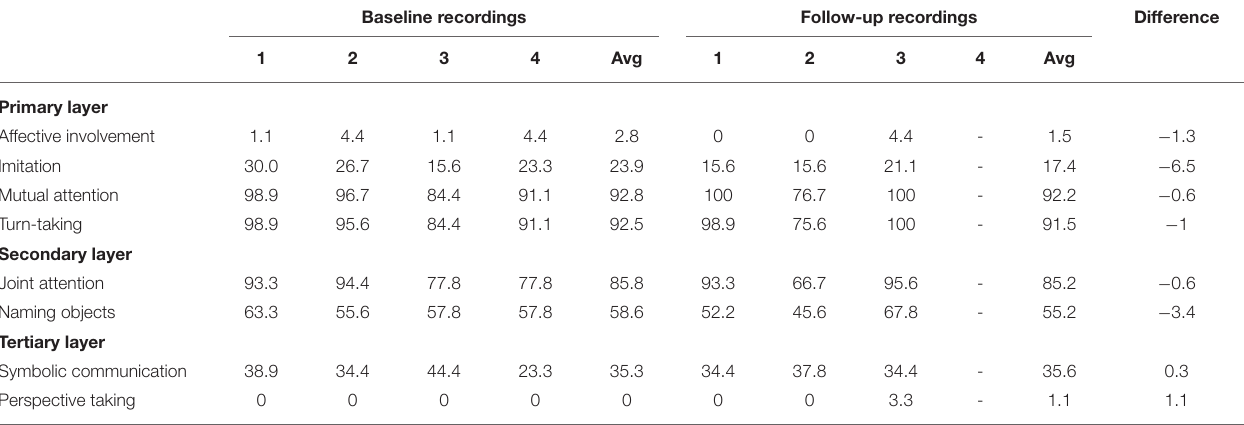
TABLE 8 | Percentage presence of LCM behaviors and difference in presence between baseline and follow-up recordings for dyad 6. Baseline recordings Follow-up recordings